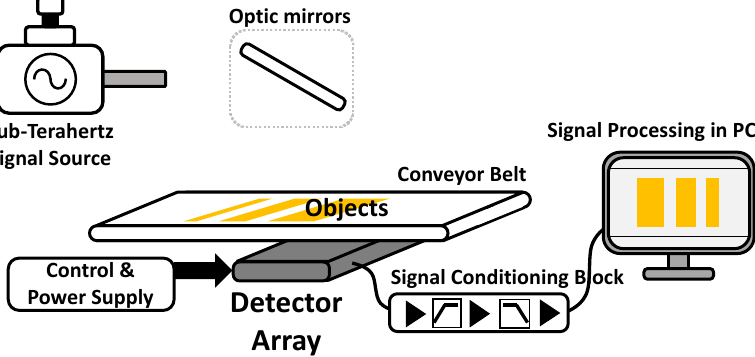
Figure 1. Sub-terahertz full-wave imaging system for the target objects on a conveyor belt.